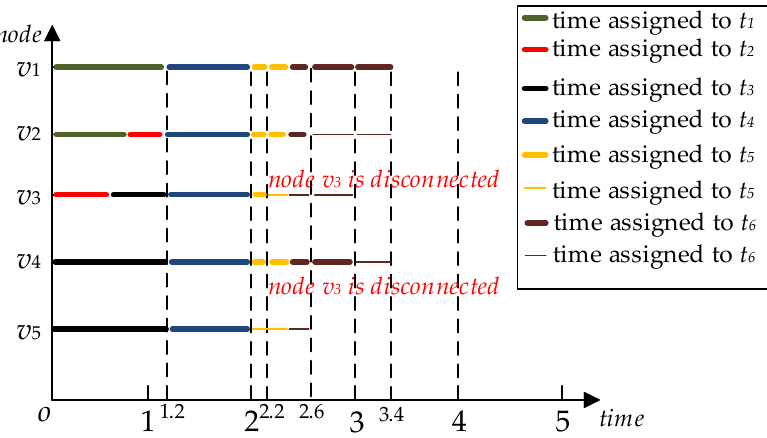
Figure 9. The specific task assignment of the EFTT algorithm.